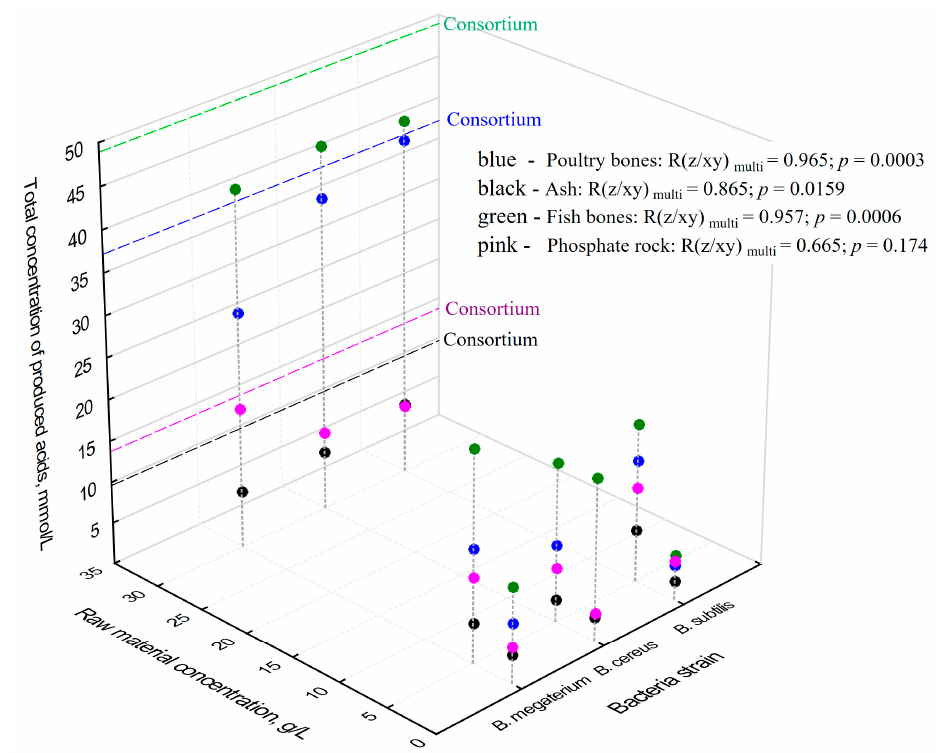
Figure 2. The influence of dose of raw material (g/L) and kind of bacterial strain on the total amount of produced acids (mmol/L): poultry bones (blue), ash (black), fish bones (green), phosphate rock (pink). Dashed lines represent the concentrations of produced acids obtained in the culture of microbial consortium when 30 g/L of raw material was used.